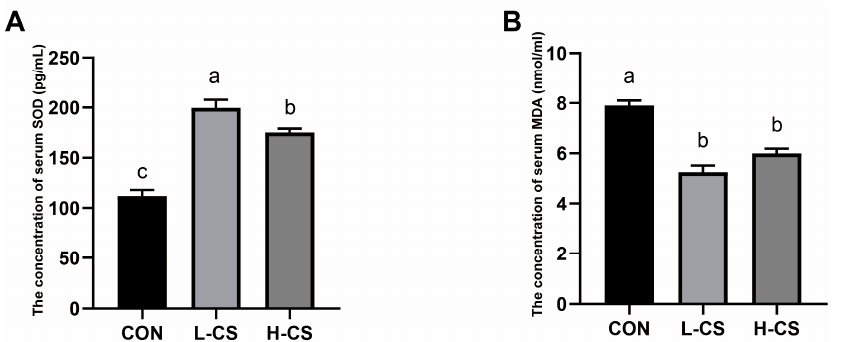
Figure 1. The effects of chitosan on anti-oxidative status in serum of cats: ( A ) Superoxide dismutase (SOD); ( B ) Malonaldehyde (MDA). Note: CON represents basic diet; L-CS, basic diet containing 500 mg/kg chitosan; H-CS, basic diet containing 2000 mg/kg chitosan; and SEM, standard error of means. Values are presented as means ± SEMs, n = 10. Different letters on the top of the column represent significant differences ( p < 0.05).